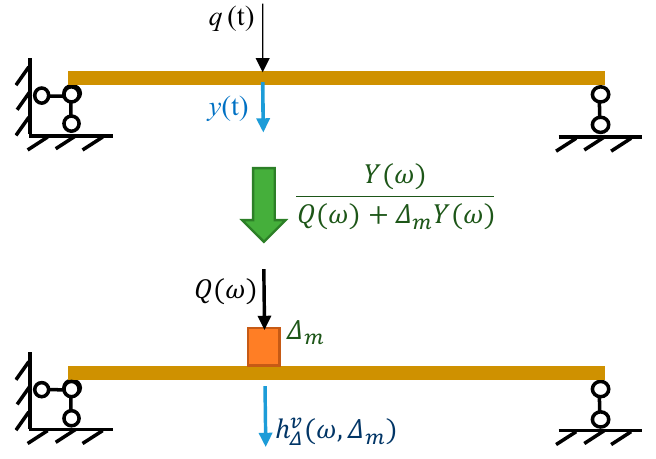
Figure 1. Diagram of the virtual mass construction.